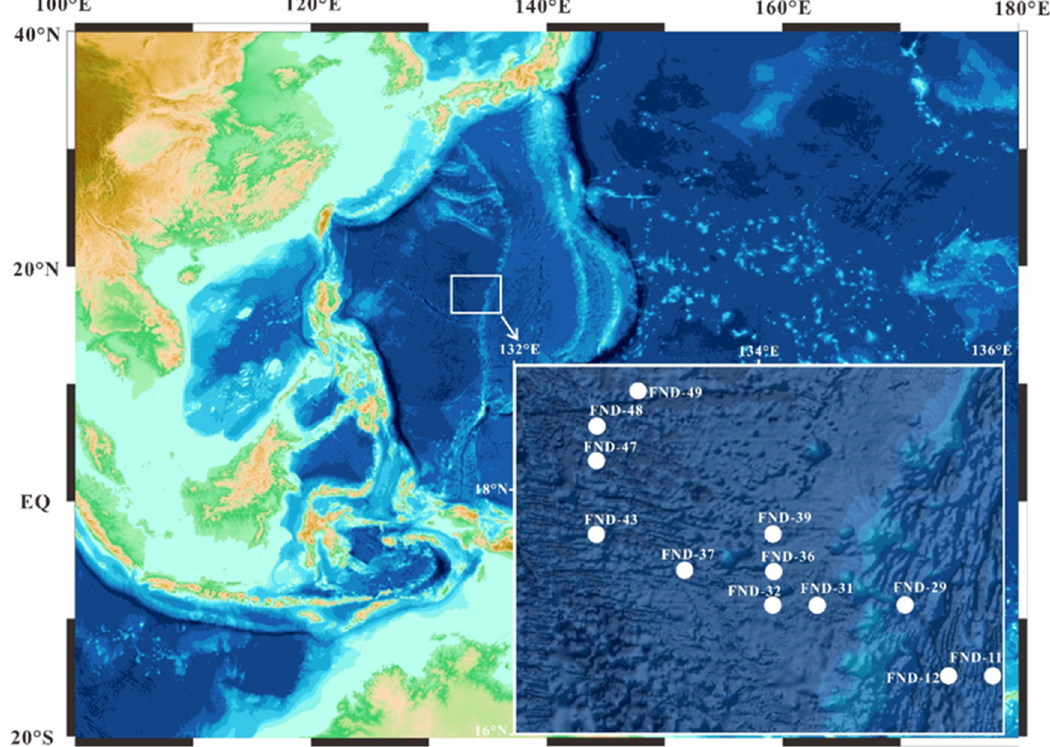
Figure 1. Sample sites of Fe–Mn nodules in this